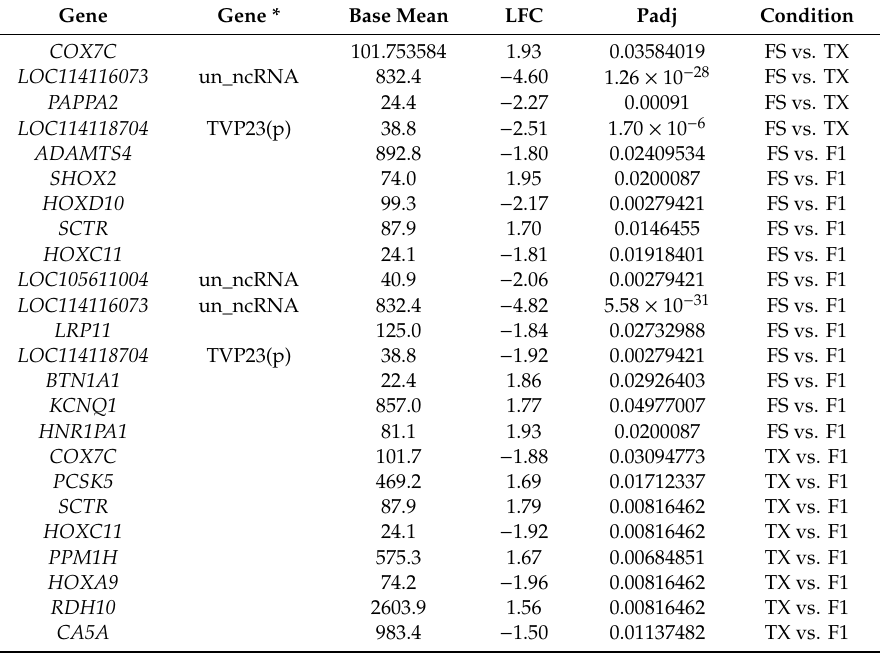
Table 4. List of genes di ff erentially expressed because of the flushing diet in Finnsheep (FS), Texel (TX) and F1 crosses (F1). Gene IDs lacking gene name and / or descriptions (marked with an *) were checked again in the NCBI to retrieve additional